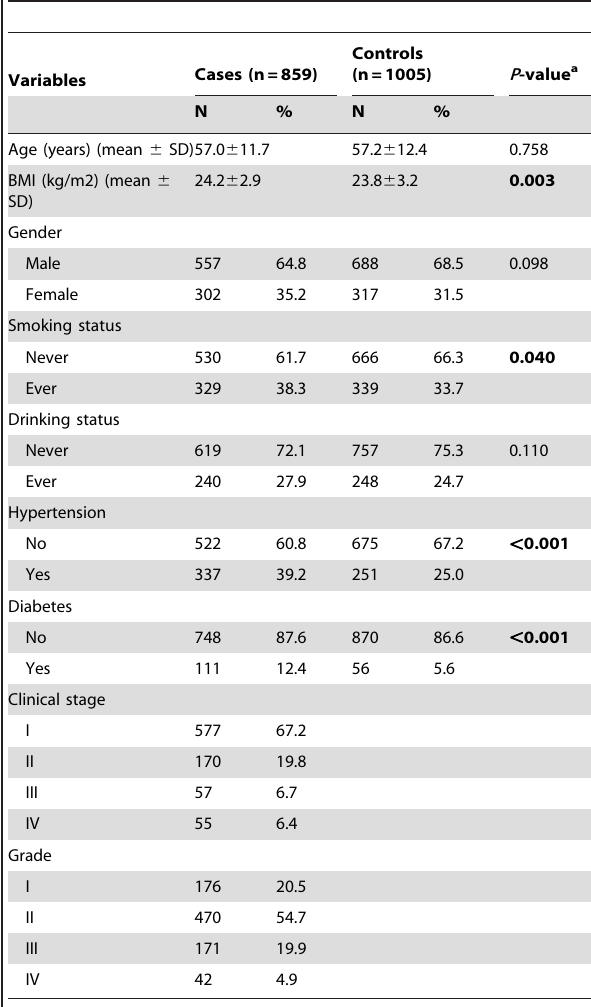
Table 1. Distribution of selected variables between the clear cell renal cell carcinoma cases and control